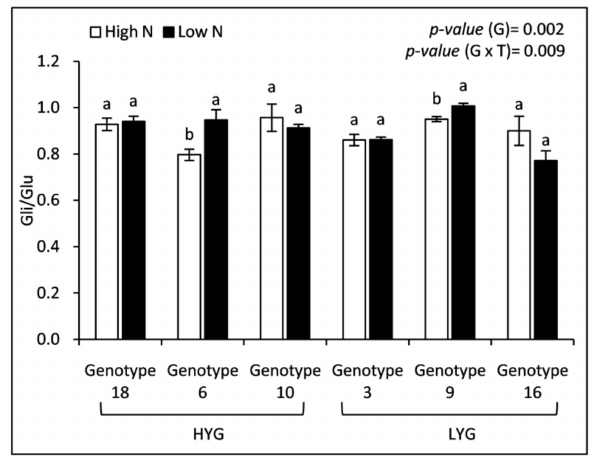
Figure 4. Grain gliadin to glutenin ratio (Gli / Glu) of 6 wheat genotypes fertilized by two nitrogen levels (High and Low). Data correspond to the means ± standard error (n = 4). For each genotype, letters indicate significant di ff erences between the two treatment. At p < 0.5. p -values corresponds to two-way ANOVA analysis. HYG: High-yielding genotypes, LYG: Low-yielding genotypes, G: Genotype, T: